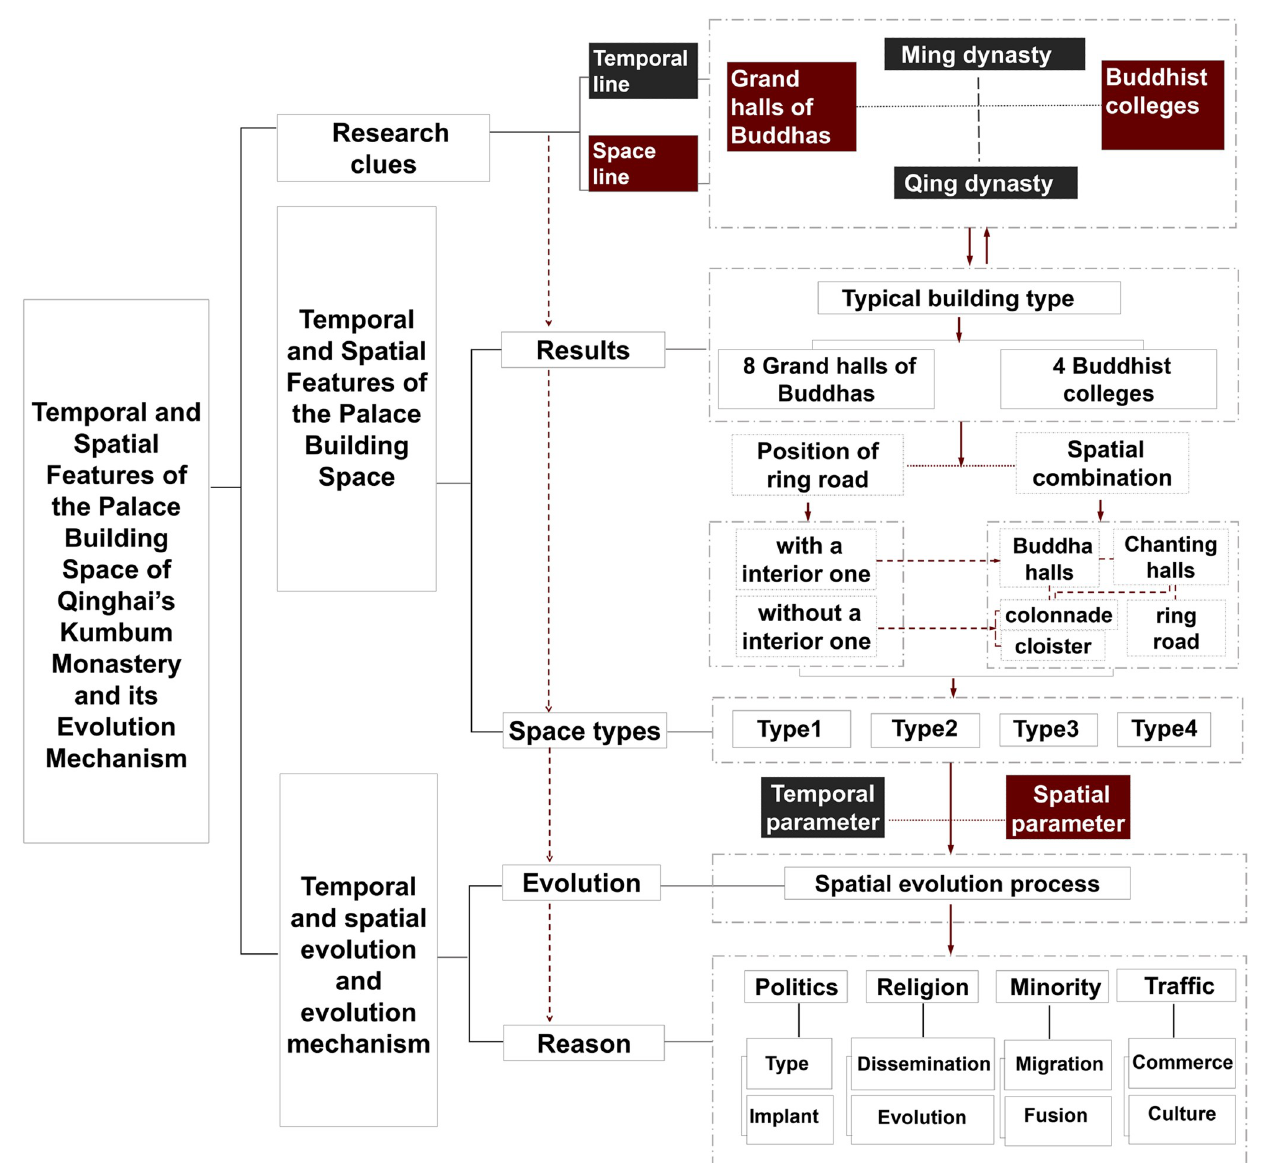
Fig 3. Research method